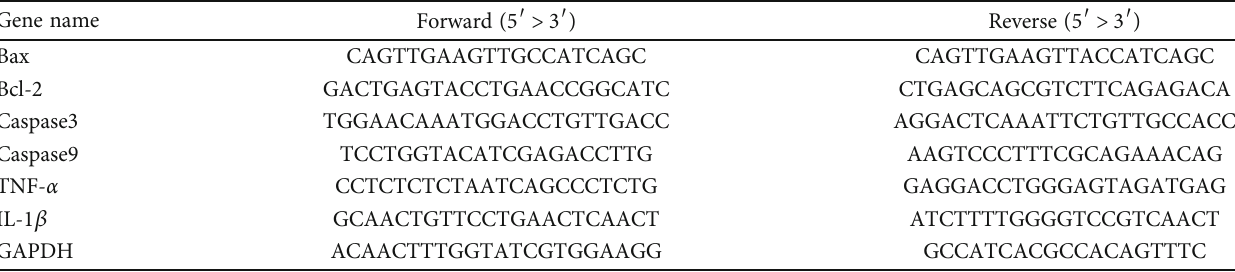
Table 1: Real-time PCR